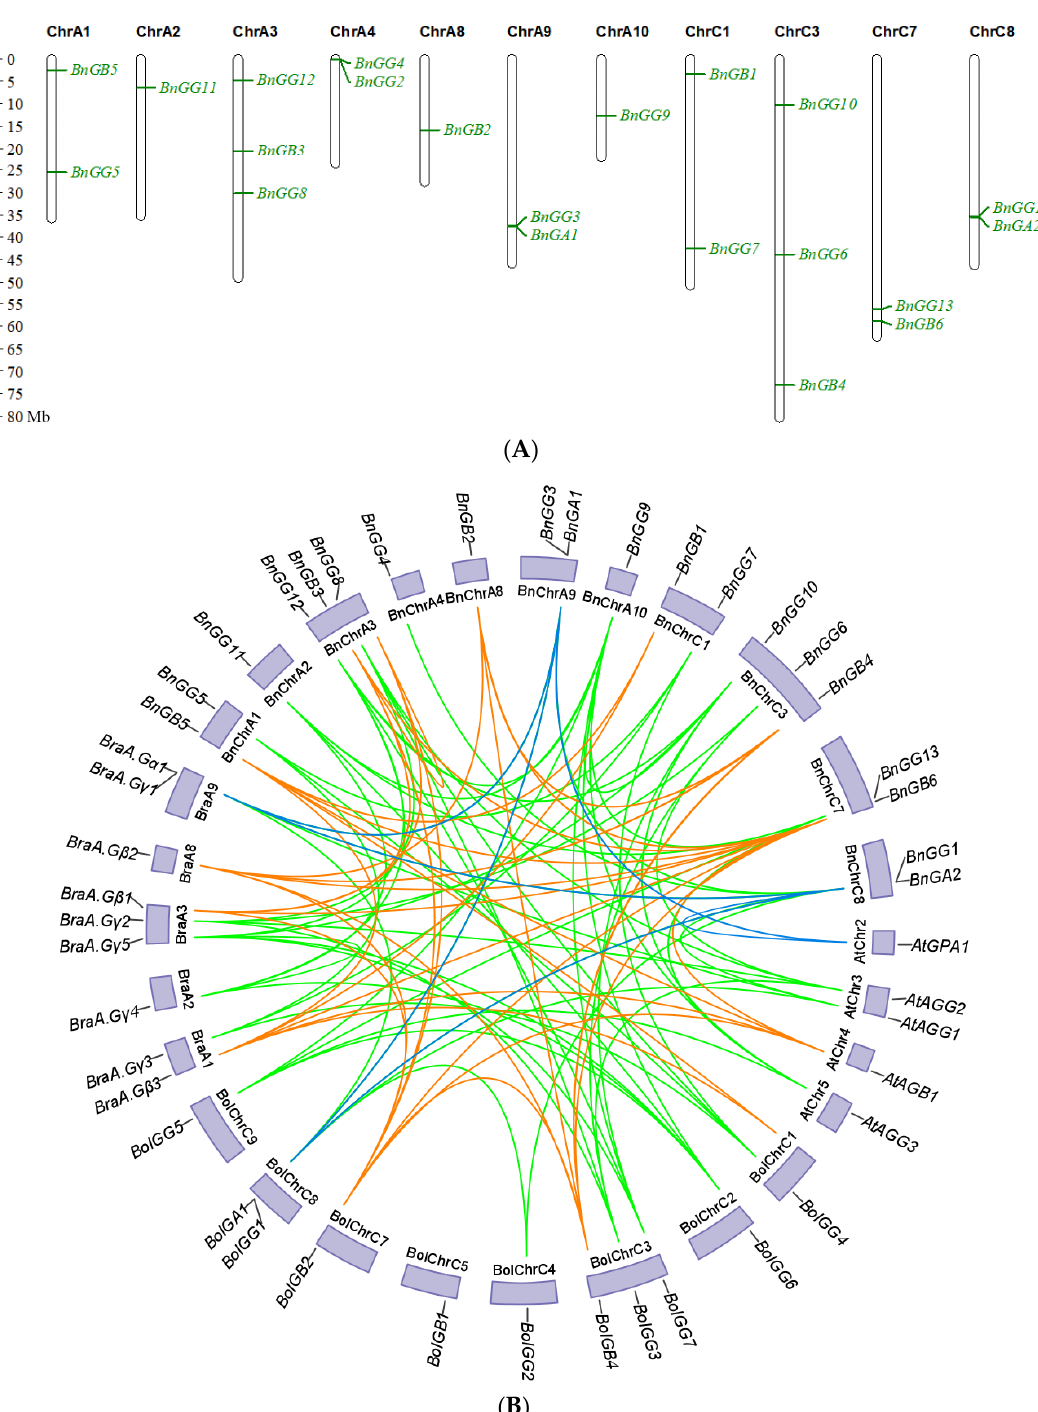
Figure 4. Chromosomal location of B. napus G-proteins ( A ) and syntenic relationships of G-protein in A. thaliana , B. napus , B. rapa , and B. oleracea ( B ). ( B ): blue lines represent G α synteny, orange lines represent G β synteny, green lines represent G γ synteny.